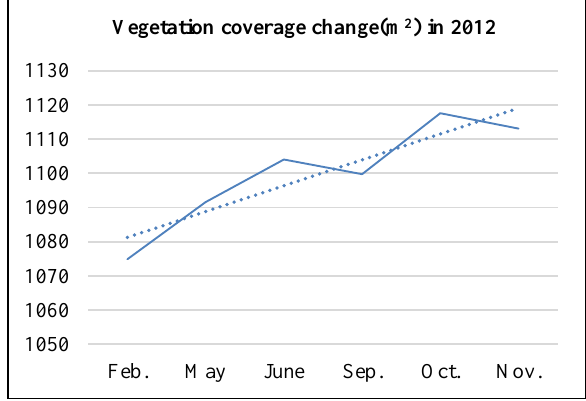
Figure 7. the typical island and sandbar vegetation change in